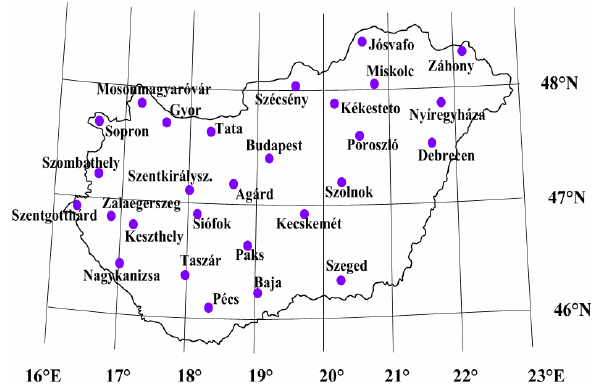
Figure 2. Figure 2. Relative frequencies of wind speed values greater than 5m / s at 10m height over